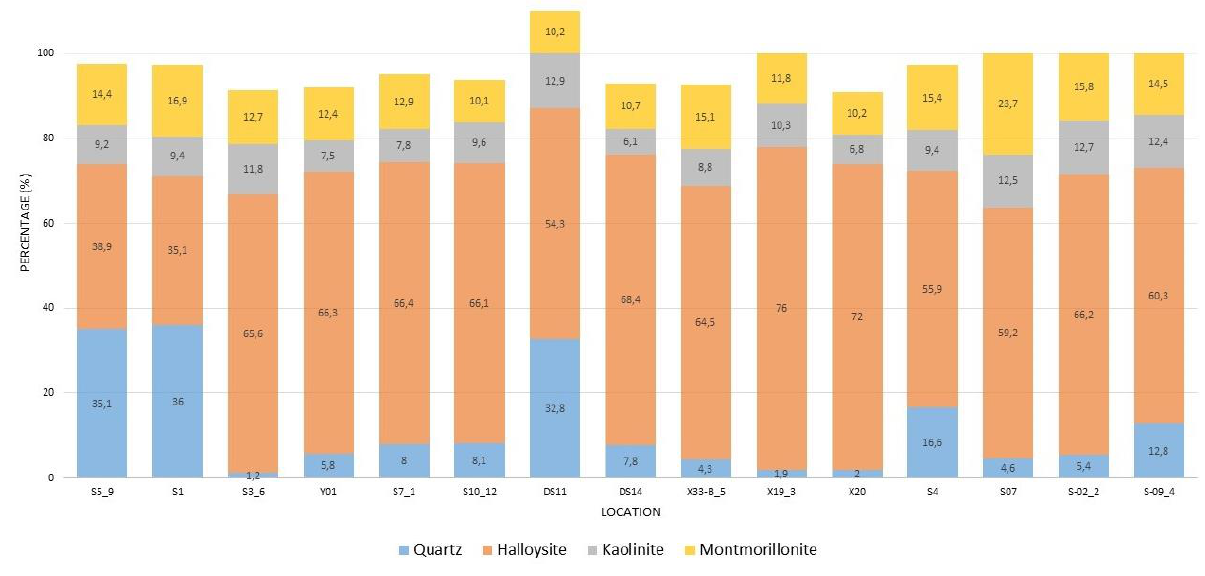
Fig. 3. Percentage of clay